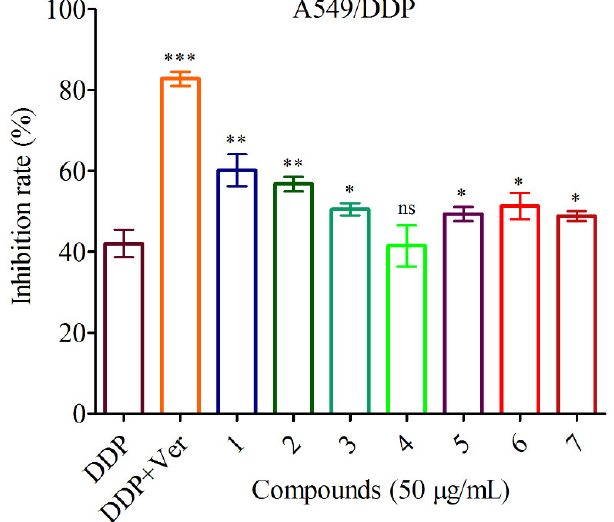
Figure 7. Reversal activities of the isolates at concentration of 50 µg/mL against A549/DDP. DDP: cisplatin; Ver: the positive drug verapamil. *** p < 0.001, ** p < 0.01, * p < 0.05 and ns p > 0.05 compared to the control group (DDP), respectively. The following are the same.